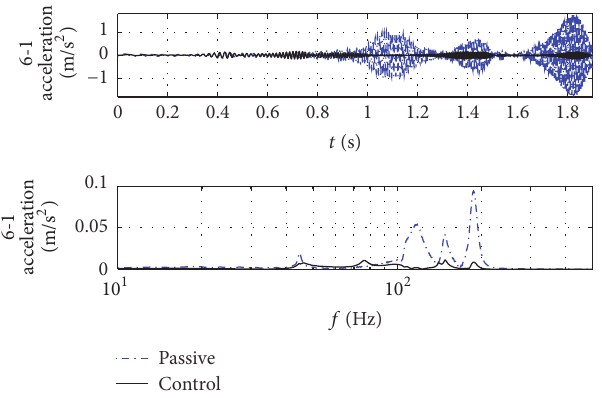
Figure 16: Comparison time-frequency domain curves of accelera- tion response of position 6-1 on the isolation system before and after being controlled under double linear swept sine interference.